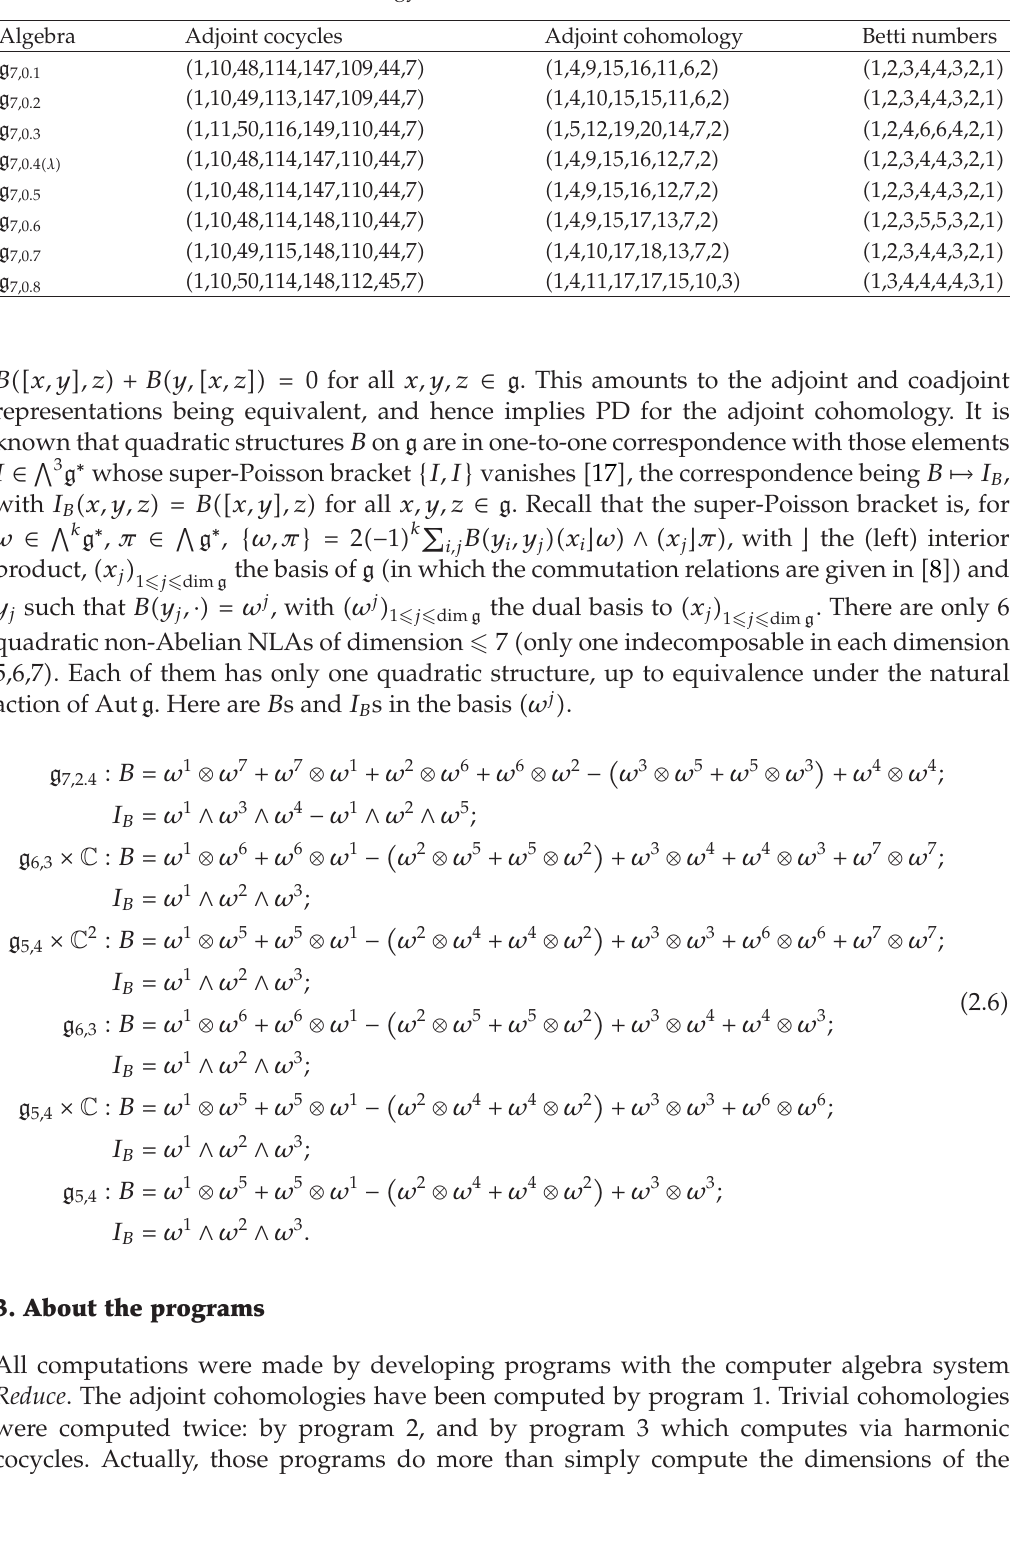
Table 3: Cohomology table for NLAs of dimension 7: rank